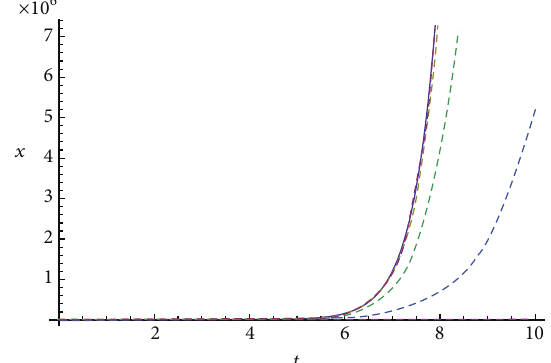
Figure 1: Plots of the exact solution 𝑥 1 (𝑡) and the RPS solutions (𝑡) , 𝑘 = 5, 10, 15, 20 , for (33) and (34) on [0,10] , where 𝑥 𝑥 𝑘 1 (𝑡) are represented, respectively, by straight and dashed lines. 𝑥 𝑘 1